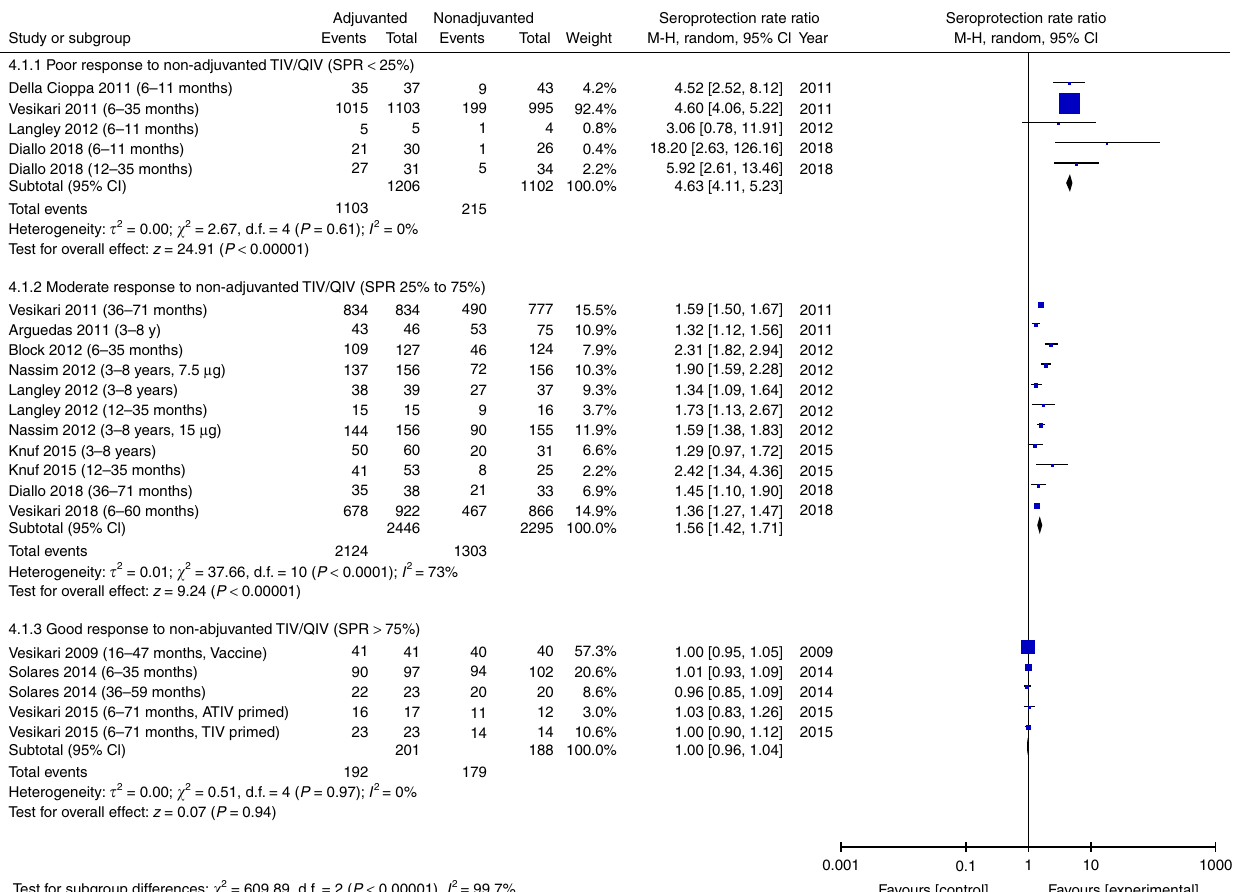
signi fi cantly superior to that after non-adjuvanted counterparts (weighted RR: 7.9; 95% CI: 6.7 – 9.4; I 2 : 0%). In contrast, in the good response group, adjuvanted and non-adjuvanted arms had an equally good post-vaccination seroprotection rate (weighted RR: 1.0; 95% CI: 0.97 – 1.05; I 2 : 0%).